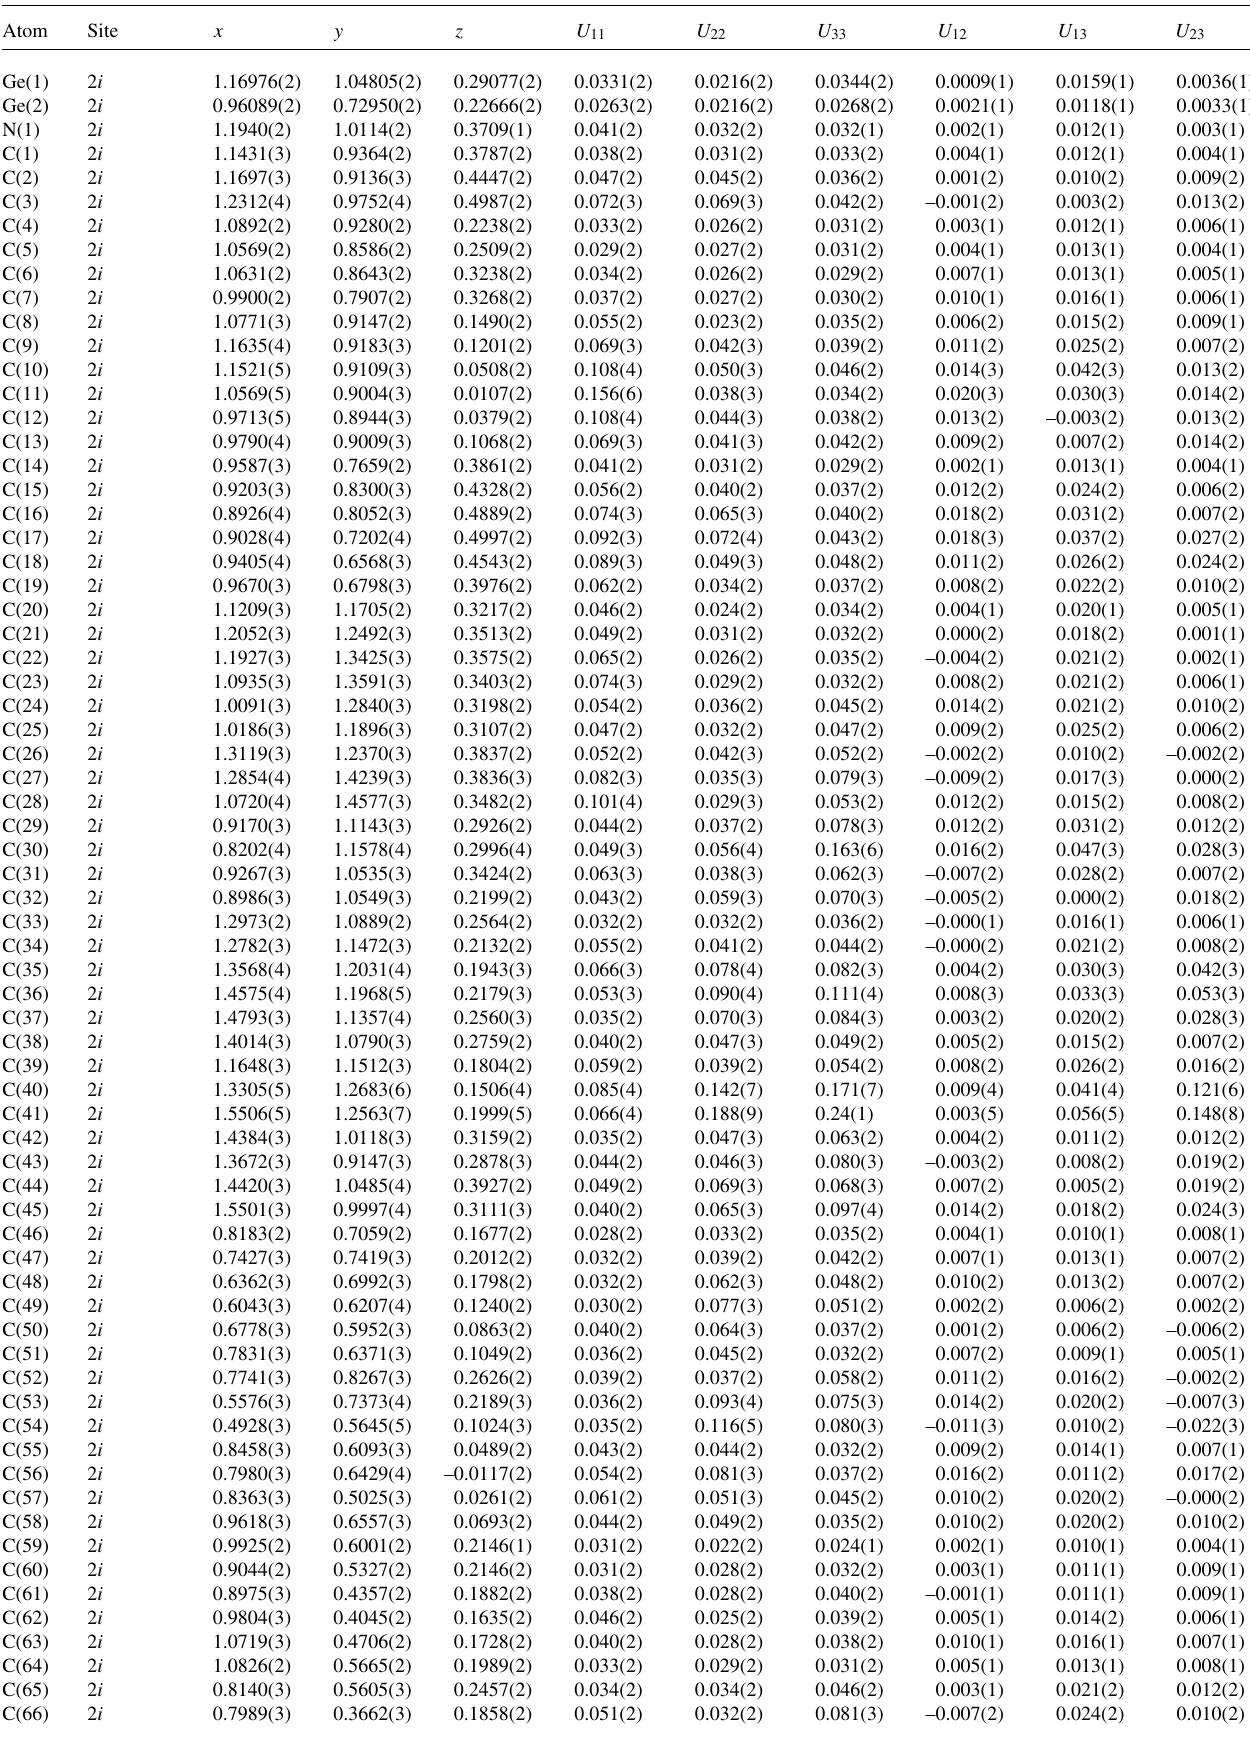
Table 3. Atomic coordinates and displacement parameters (in Å 2 )